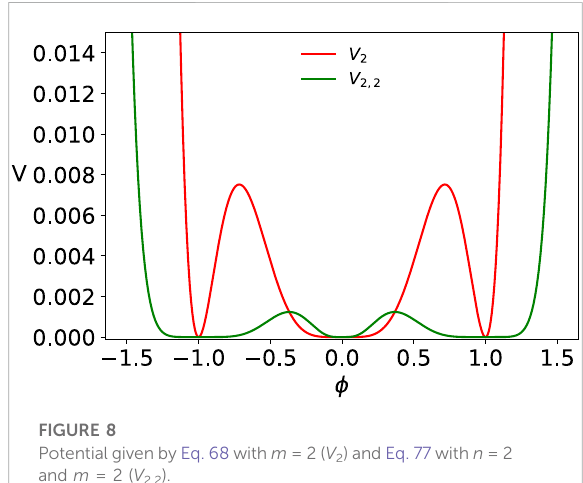
FIGURE 7 Potential given by Eq. 68 with m = 1 ( V 1 ) and Eq. 77 with n = 1 and m = 1 ( V 1,1 ).